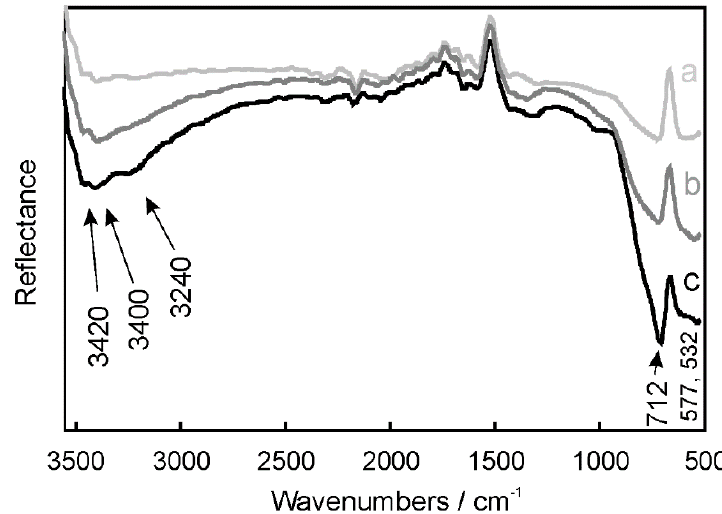
Figure 3. Attenuated total reflectance Fourier transform infrared (ATR-FTIR) spectra of NiAl 2 O 4 after annealing at ( a ) 400, ( b ) 600 and ( c ) 800 °C.